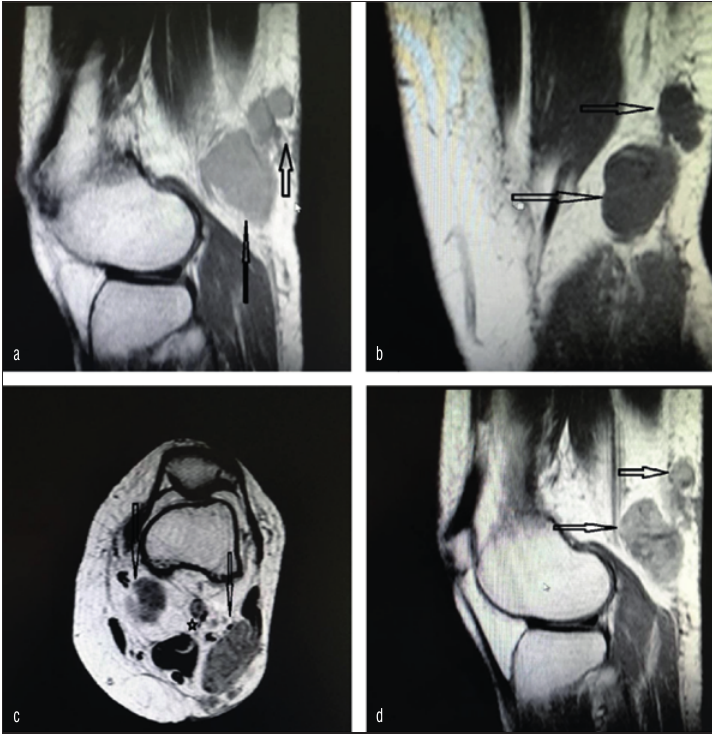
Figure 1. Magnetic resonance imaging of knee and popliteal fossa. Synovial sarcoma in the popliteal region behind the metaphysis of the femur and musculus vastus medialis: a) Proton density weighted sagittal view expressing hypointense, well rounded soft tissue mass, b) T1W coronal view showing multicentric, relatively well rounded T1 hypointense soft tissue masses, c) T1W axial CE view expressing the heterogeneous contrast enhancement of both masses without local invasion on vascular and other structures and d) T1W CE sagittal view showing multicentric, relatively well rounded T1 hypointense soft tissue masses